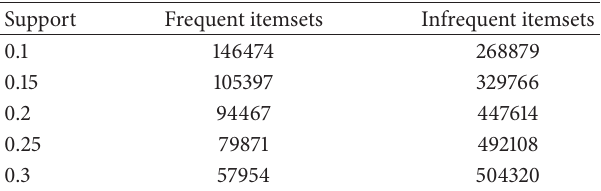
Table 2: Total generated frequent and infrequent itemsets using different support values.